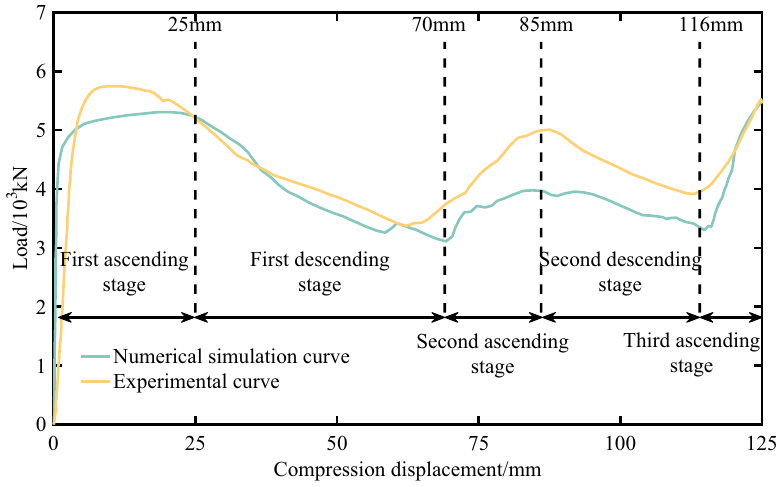
Figure 5. Load-compression displacement curve of numerical simulation and experiment.